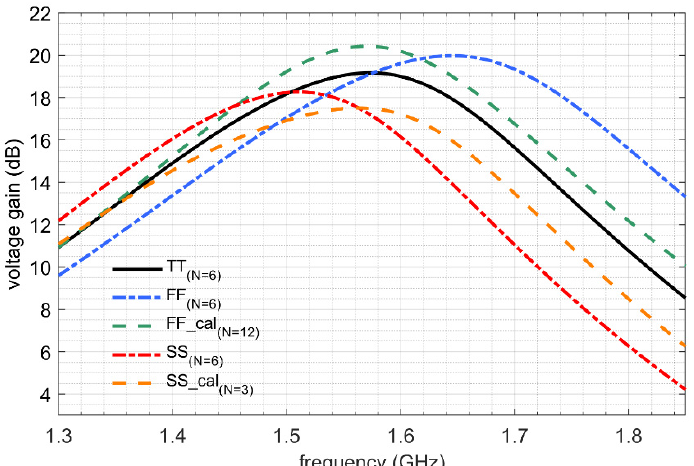
Figure 14. Voltage gain for different process corners with calibration (FF_cal, N = 12; SS_cal, N = 3) and without calibration (TT, FF, SS) with nominal configuration of the switched capacitor bank ( N = 6). SS case: slow process corner (slow transistors, high capacitances, high resistances); FF case: fast process corner (fast transistors, low capacitances, low resistances); TT case: typical process corner. All simulations had a nominal temperature of 27 °C and nominal VDD = 1.5 V.